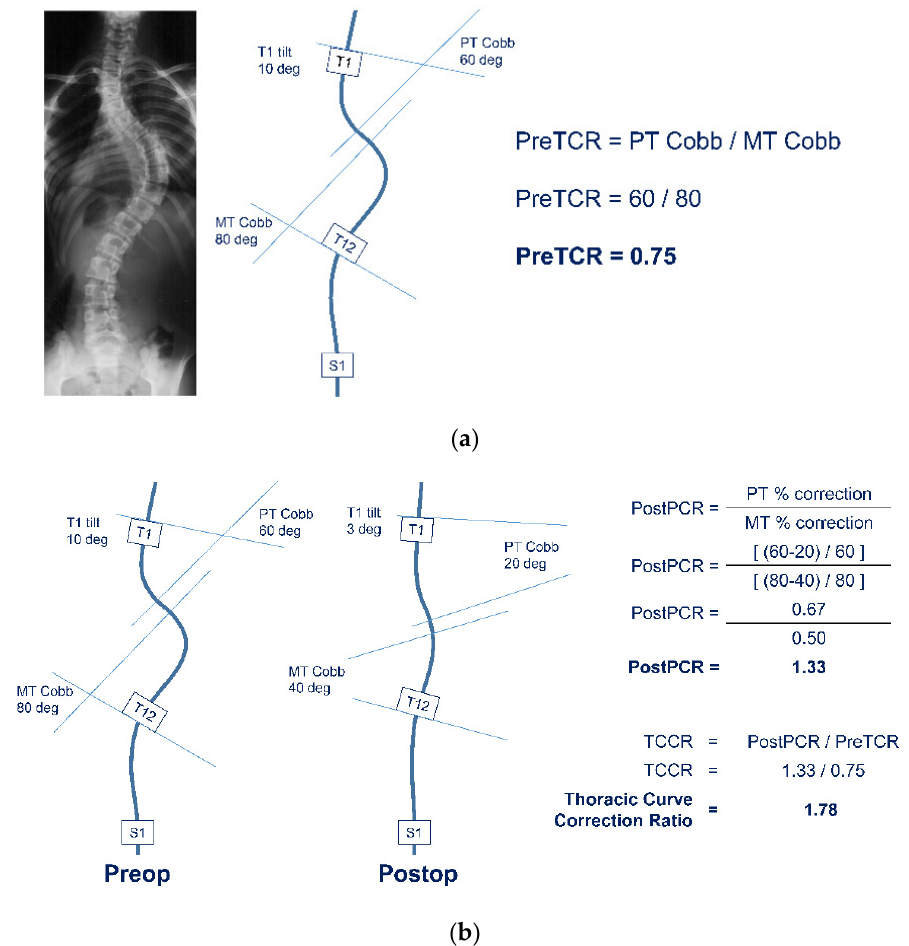
Figure 1. ( a ) Case example demonstrating calculation of Preoperative Thoracic Curve Ratio (PreTCR) from the Proximal Thoracic (PT) and Main Thoracic (MT) Cobb angles. ( b ) Continuation of case example from Figure 2a demonstrating calculation of postoperative Thoracic Curve Correction Ratio (TCCR).